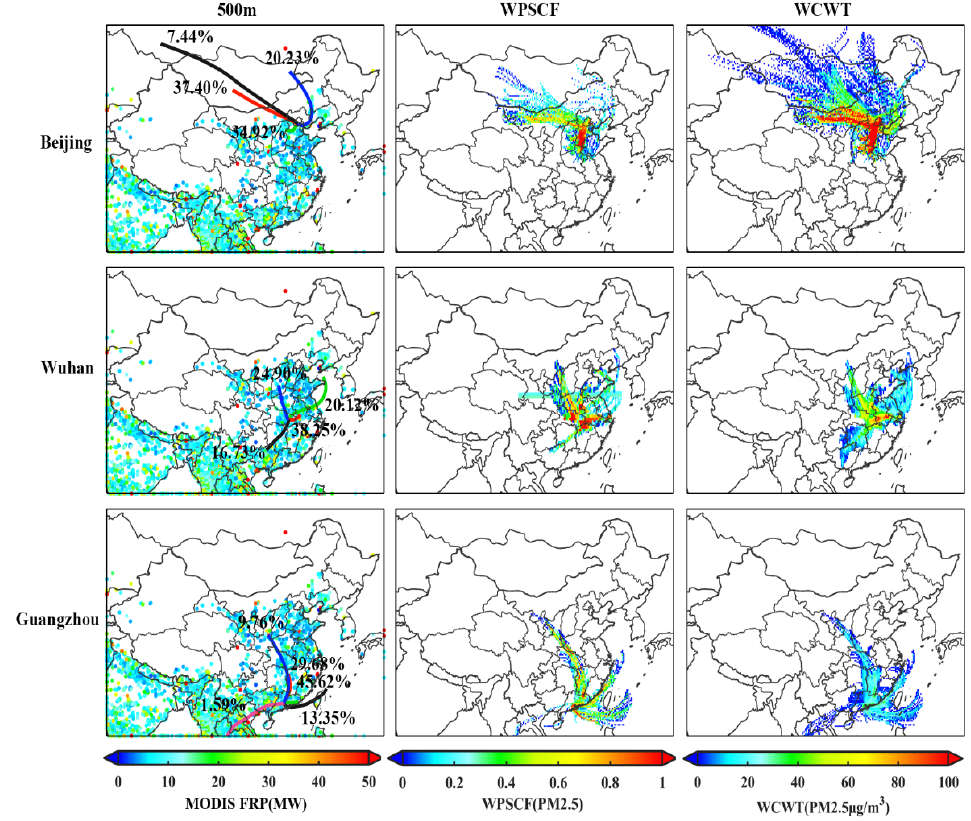
Figure 12. Mean 48 h backward-trajectory clusters (500 m) of Beijing, Wuhan, and Guangzhou and distribution of potential source of PM 2.5 during CLD-I period. The bottom map of the first column of backward-trajectory air masses is the MODIS FRP.